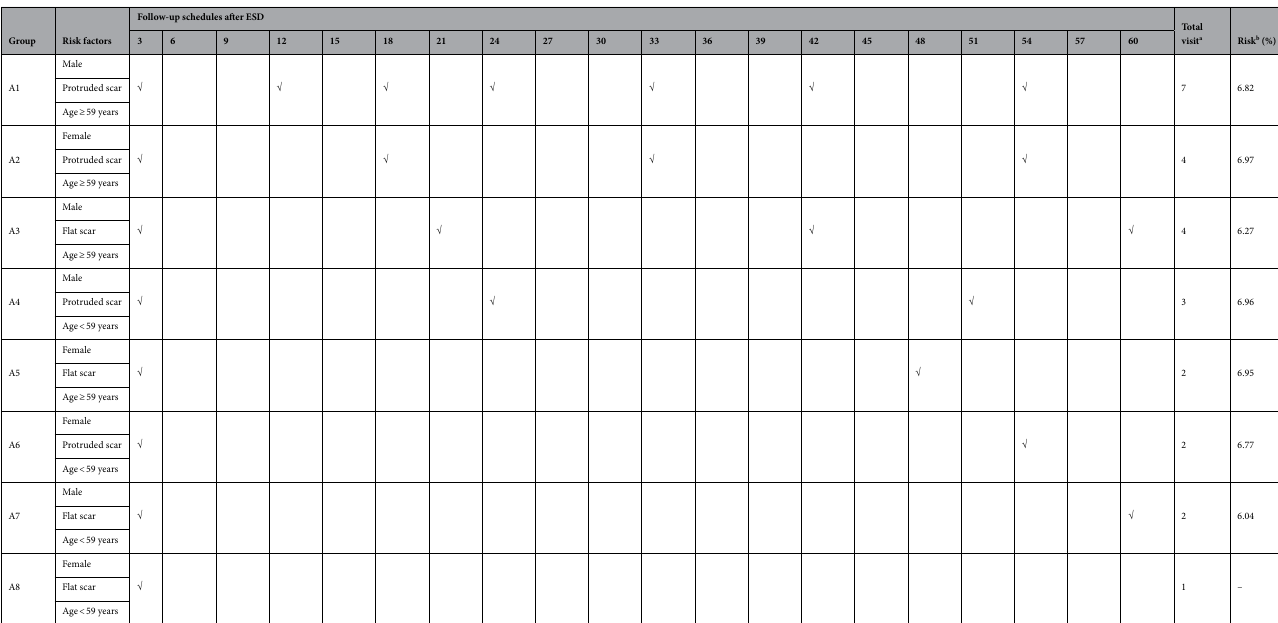
Table 4. Suggested surveillance interval according to risk factor categorization in patients with gastric adenoma after endoscopic submucosal dissection with curative resection. ESD, endoscopic submucosal dissection. a Predicted visit number by groups up to 60 months. b Mean recurrence rate between